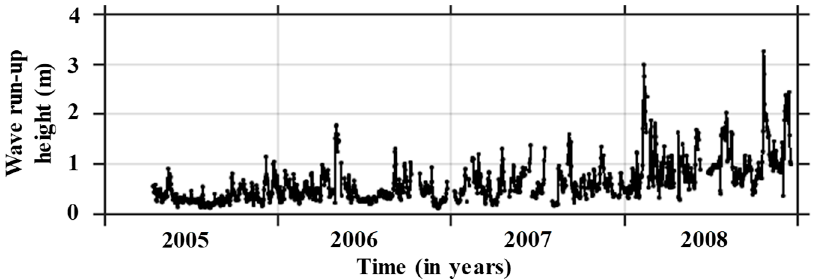
Figure 20. The wave run-up height (at x = − 49 m) estimated using an empirical wave run-up formula [44].